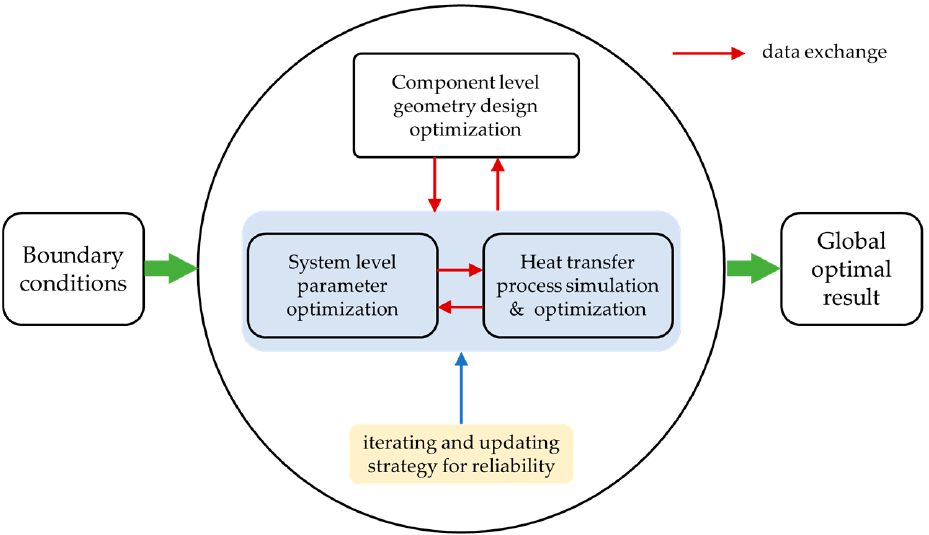
Figure 6. Sketch of the proposed synergetic optimization method.